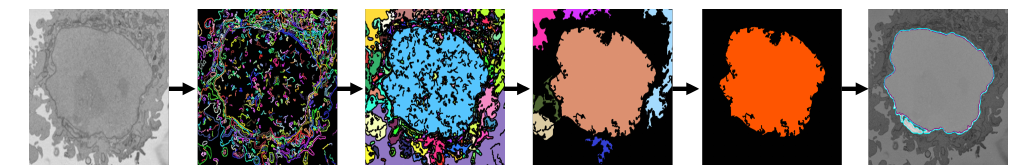
Figure 4. Graphical illustration of the image processing algorithm. The image is low-passed filtered to reduce noise, edges are generated and then the regions that are not covered by edges become superpixels. Morphological operations are used to discard all regions except the one that corresponds to the nucleus, which in this case is the large central one. Finally, closing operations are used to fill the small gaps and provide a smooth nuclear